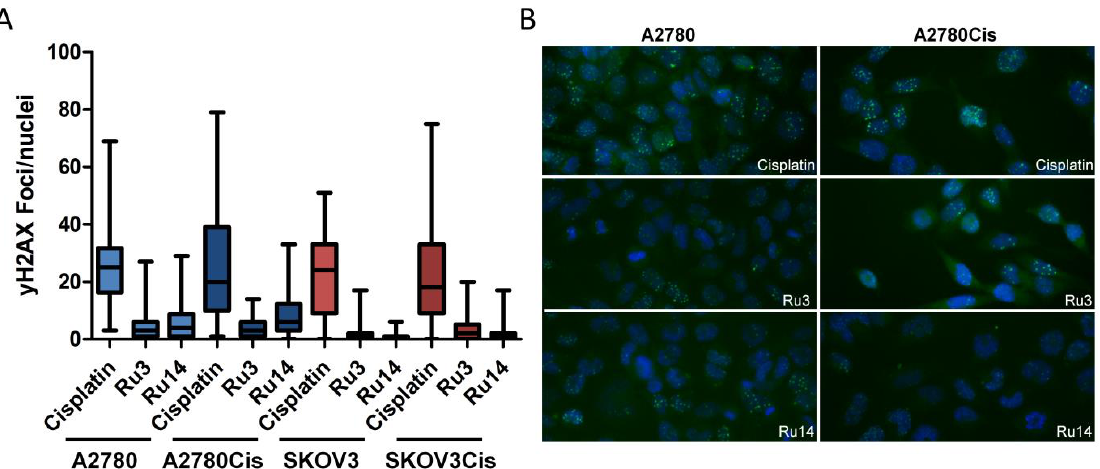
Figure 8. γ H2AX foci analysis (DNA damage) after 24h incubation with IC50 concentrations for Cisplatin, Ru3 and Ru14. ( A ): Box plot of quantitative analysis for γ H2AX foci per nuclei (n > 100). ( B ): Exemplary pictures for A2780par and A2780Cis for all substances. γH2AX foci are shown by green signal (Alexa488-labelled secondary antibody) and nuclei are stained with DAPI (4',6-Diamidino-2-phenylindol, blue).